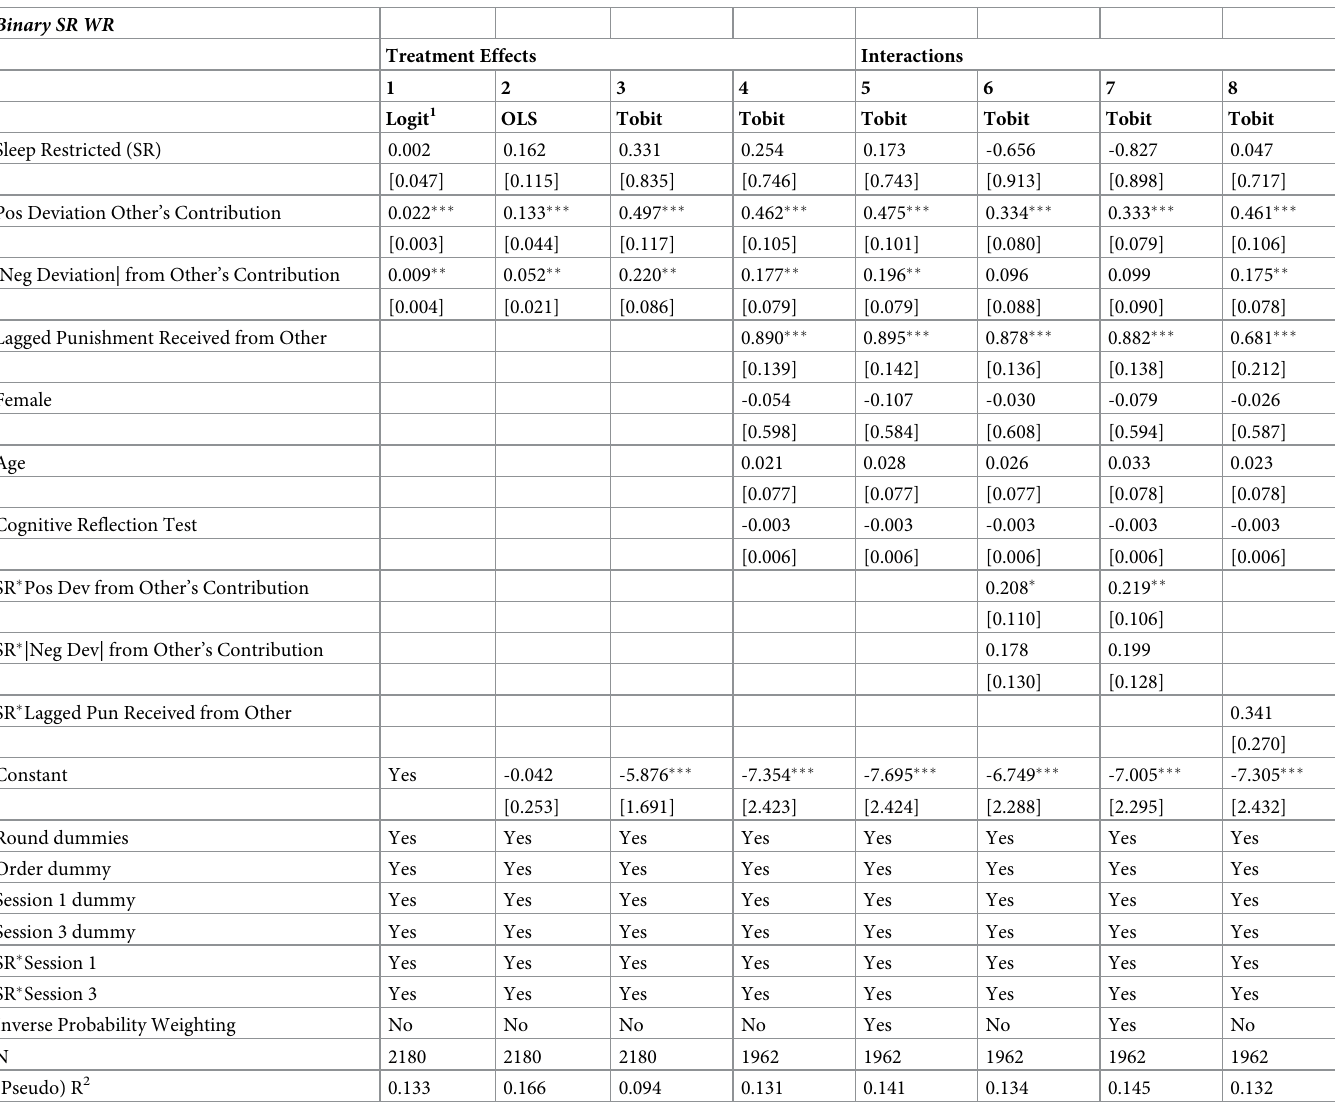
Table 6. Regression results for punishment sent—compliant subjects only. Binary SR